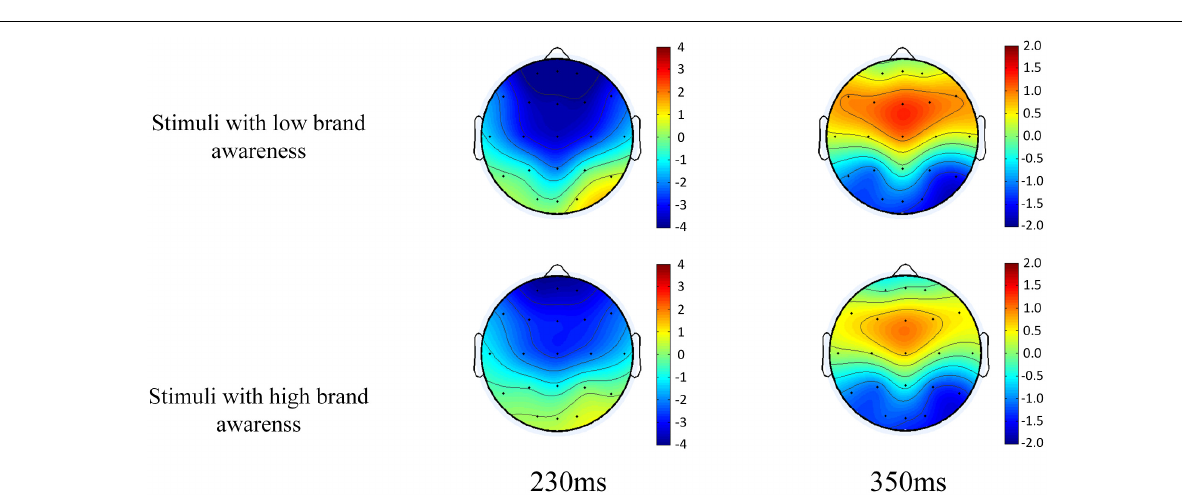
seen, whether the stimuli were presented with a low or high degree of brand awareness. For the P3, we obtained significant main effects for brand awareness [ F (1, 15) = 11.731, p = 0.004], but distribution [ F (2, 30) = 1.592, p = 0.220] and interaction